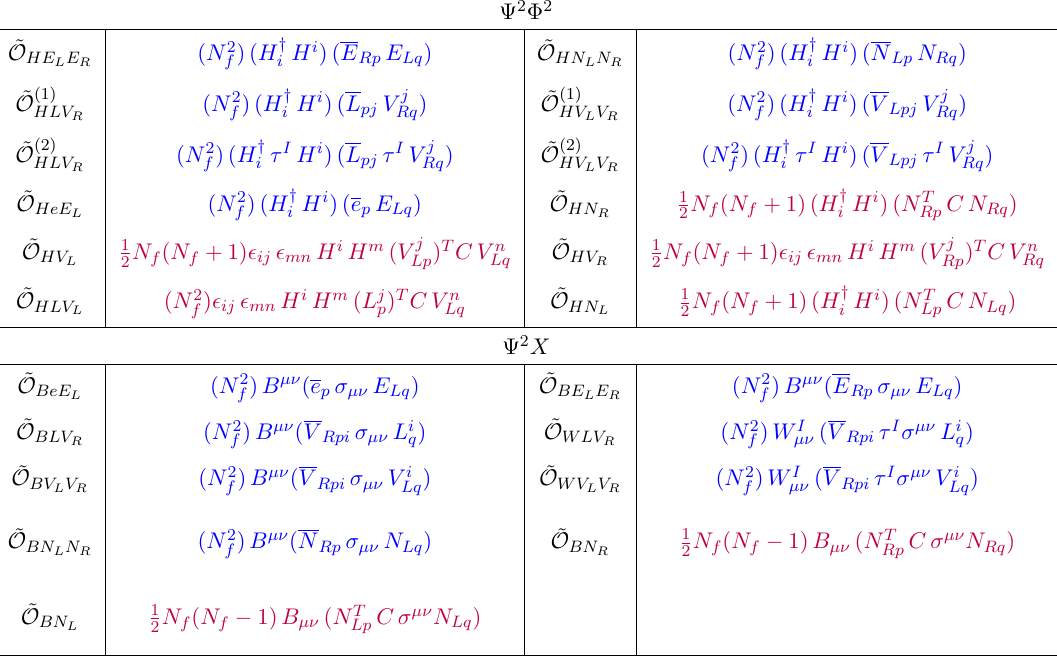
Table 10 . SM extended by Vector-like Leptons ( V L,R , E L,R , N L,R ): additional operators of dimen- sion 5. i, j, m, n are the SU(2) indices and p, q = 1 , 2 , · · · , N f are the flavour indices. τ I ( I = 1 , 2 , 3) is the SU(2) generator. Operators in red violate lepton and baryon